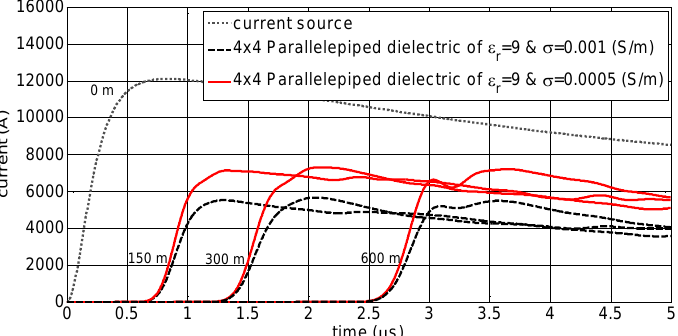
Figure 4. Current distribution along the lightning channel at different height calculated by CST-MWS for a 4 × 4 m 2 parallelepiped dielectric of ε r = 9 for σ = 0.001 S/m and σ = 0.0005 S/m. Model B 1: Wire embedded in a fictitious dielectric coating.